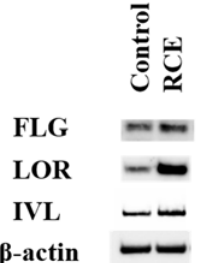
Figure 3. RCE upregulates the protein expression of FLG, LOR, and INV compared to DMSO control. RCE = 100 µ g/mL.